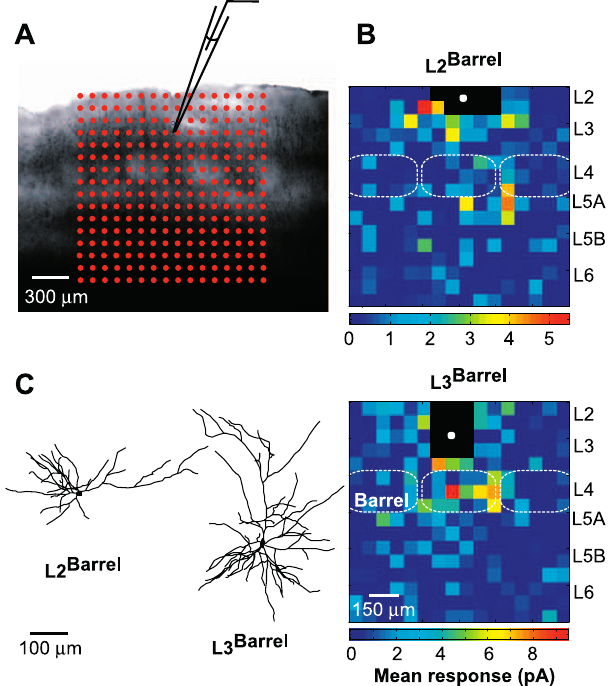
Figure 7. Laser Scanning Photostimulation Mapping of Intracortical Projections to L2/3 neurons (A) Across-barrel slice showing barrels corresponding to rows A–E (from left to right) under brightfield illumination. In this experiment, the map pattern (red grid) was centered on the septum between the barrels C and D. (B) Examples of synaptic input maps for a L2 Barrel cell (top) and a L3 Barrel cell (bottom). Black pixels are sites where glutamate uncaging evoked direct responses in the recorded cells, polluting the synaptic responses. Dashed lines indicate the barrel positions. Solid white circles show the cell body positions of the recorded neurons. (C) Examples of dendritic morphologies of L2 Barrel and L3 Barrel cells (same cells as in [B]). DOI: